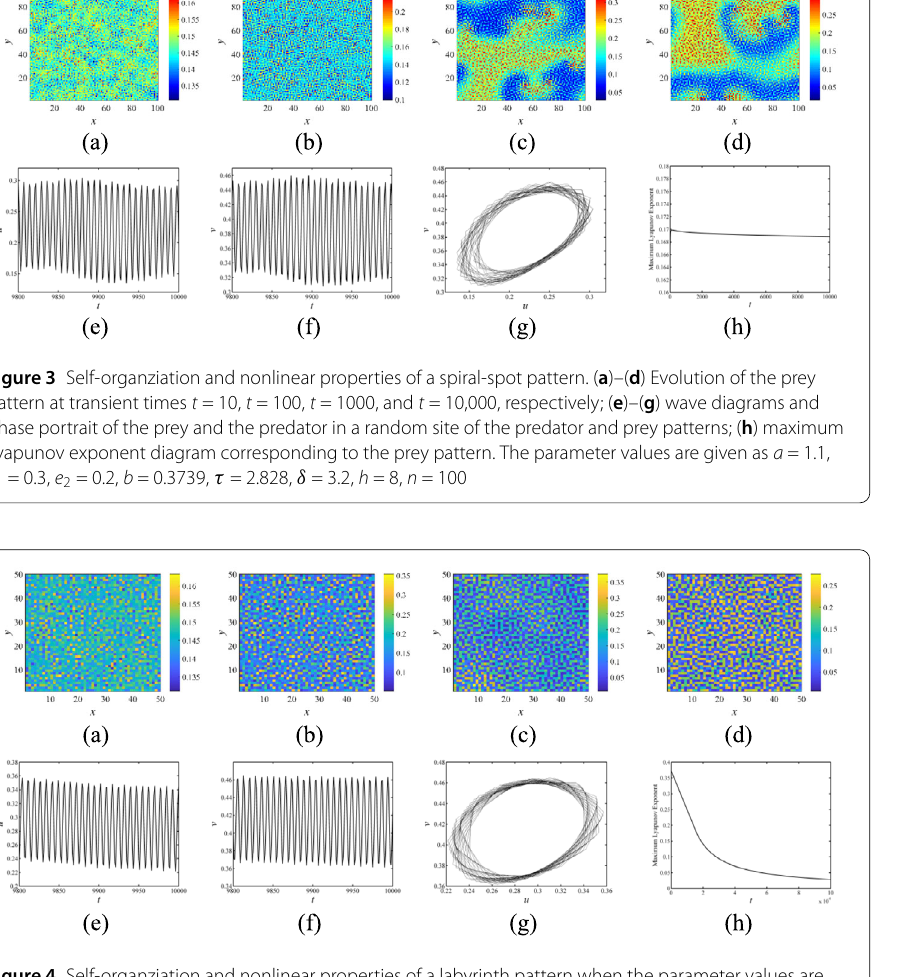
Figure 4 Self-organziation and nonlinear properties of a labyrinth pattern when the parameter values are given as a = 1.1, e 1 = 0.3, e 2 = 0.2, b = 0.3739, τ = 2.36, δ = 4, h = 8, n = 50. ( a )–( d ) Evolution of the prey pattern at transient times t = 10, t = 100, t = 500, and t = 1000, respectively; ( e )–( g ) wave diagrams, phase portrait and maximum Lyapunov exponent diagram which present same nonlinear properties like in Fig.